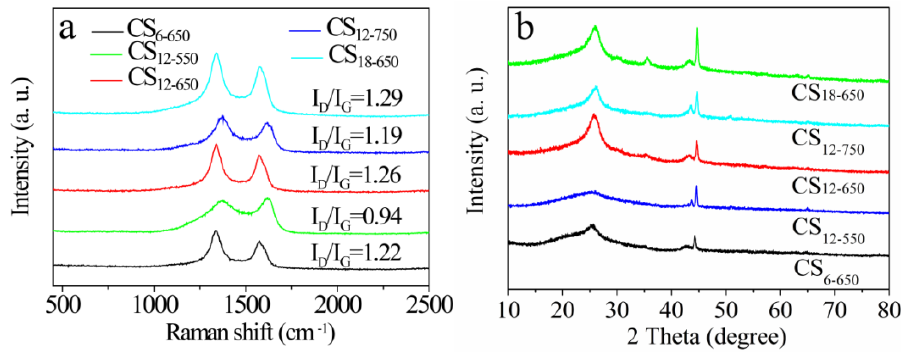
Figure 2. Raman spectra ( a ) and XRD patterns ( b ) of CSs.